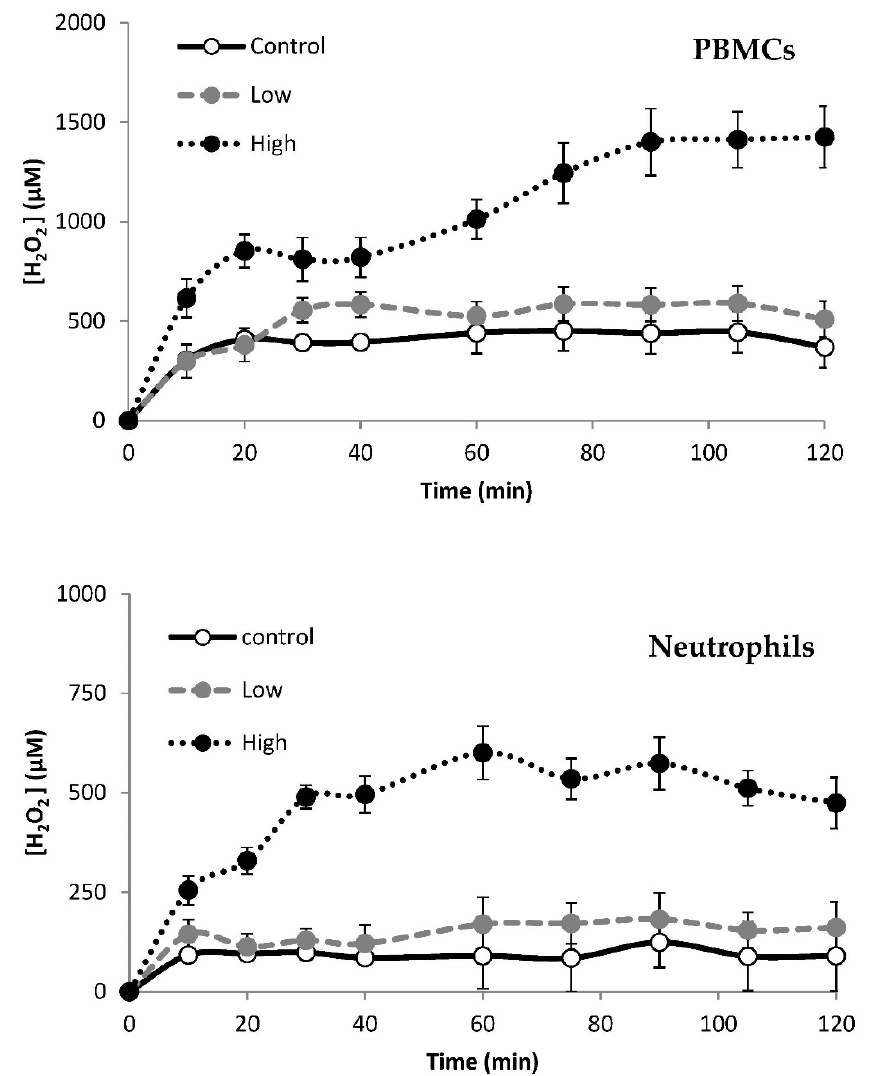
Figure 3. Levels of H 2 O 2 in the culture medium of PBMCs and neutrophils in the control and after high and low H 2 O 2 exposure by GOX addition for 2 h at 37 ◦ C. PBMCs: High indicates H 2 O 2 production rate by 1 µ g solid GOX/mL culture medium and Low indicates H 2 O 2 production rate by 0.1 µ g solid GOX/mL culture medium. Neutrophils: High indicates H 2 O 2 production rate by 15 µ g solid GOX/mL culture medium and Low indicates H 2 O 2 production rate by 5 µ g solid GOX/mL culture medium. Control indicates PBMCs or neutrophils are cultured in the medium without GOX addition.